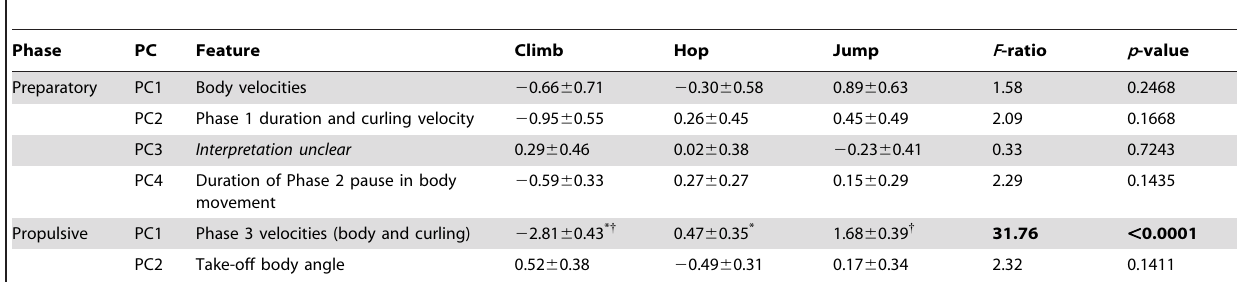
Table 2. Principal components (PC) interpretations and means for each locomotor mode for preparatory and propulsive PCA